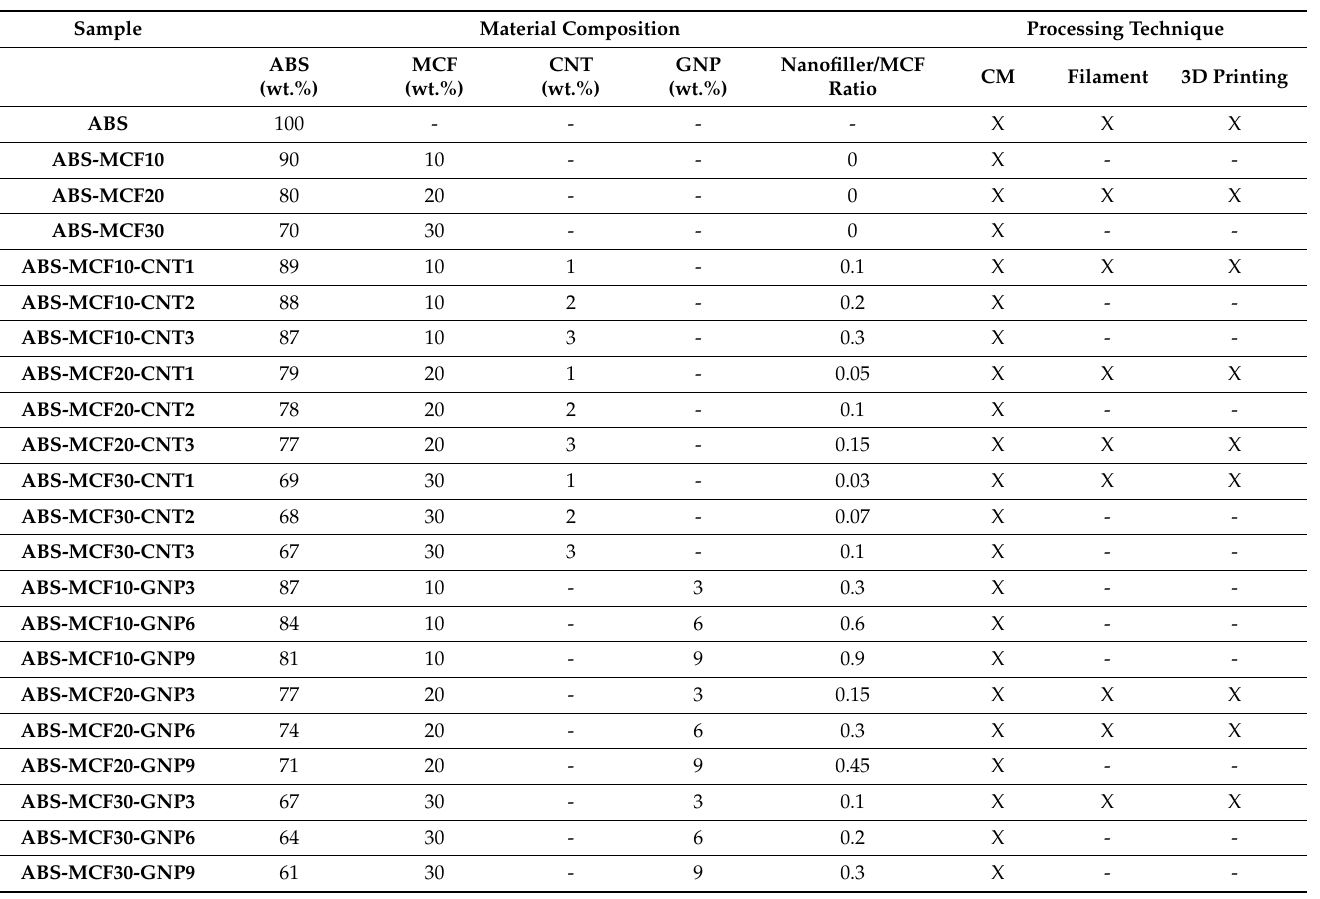
Table 2. Designation and formulation of ABS multiscale composites at different MCF/CNT and MCF/GNP percentages and fillers’ ratios, and processing techniques: compression molding (CM), filament extrusion (Filament), and 3D